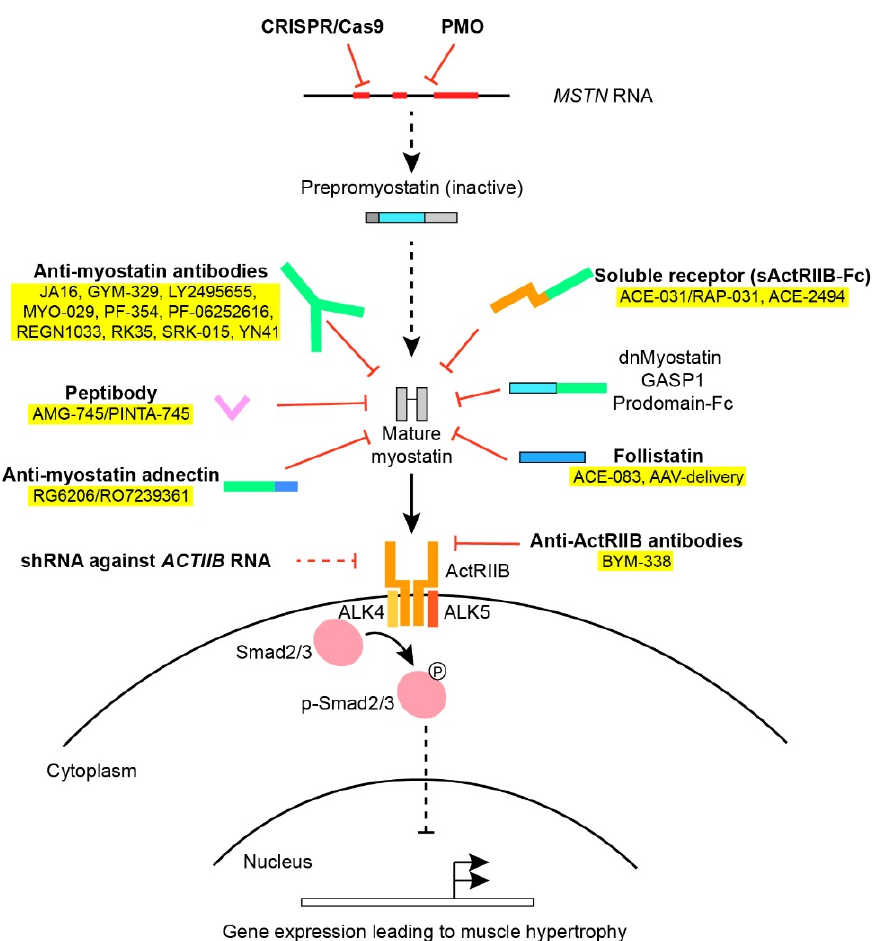
Figure 1. An overview of various approaches used in myostatin inhibition. Various factors and approaches in myostatin inhibition as outlined in sections 2 and 5. Treatments applied in clinical trials have been colored yellow. The Smad2/3 intracellular signaling pathway downstream the ActRIIB leads to altered gene transcription of muscle regulatory factors.